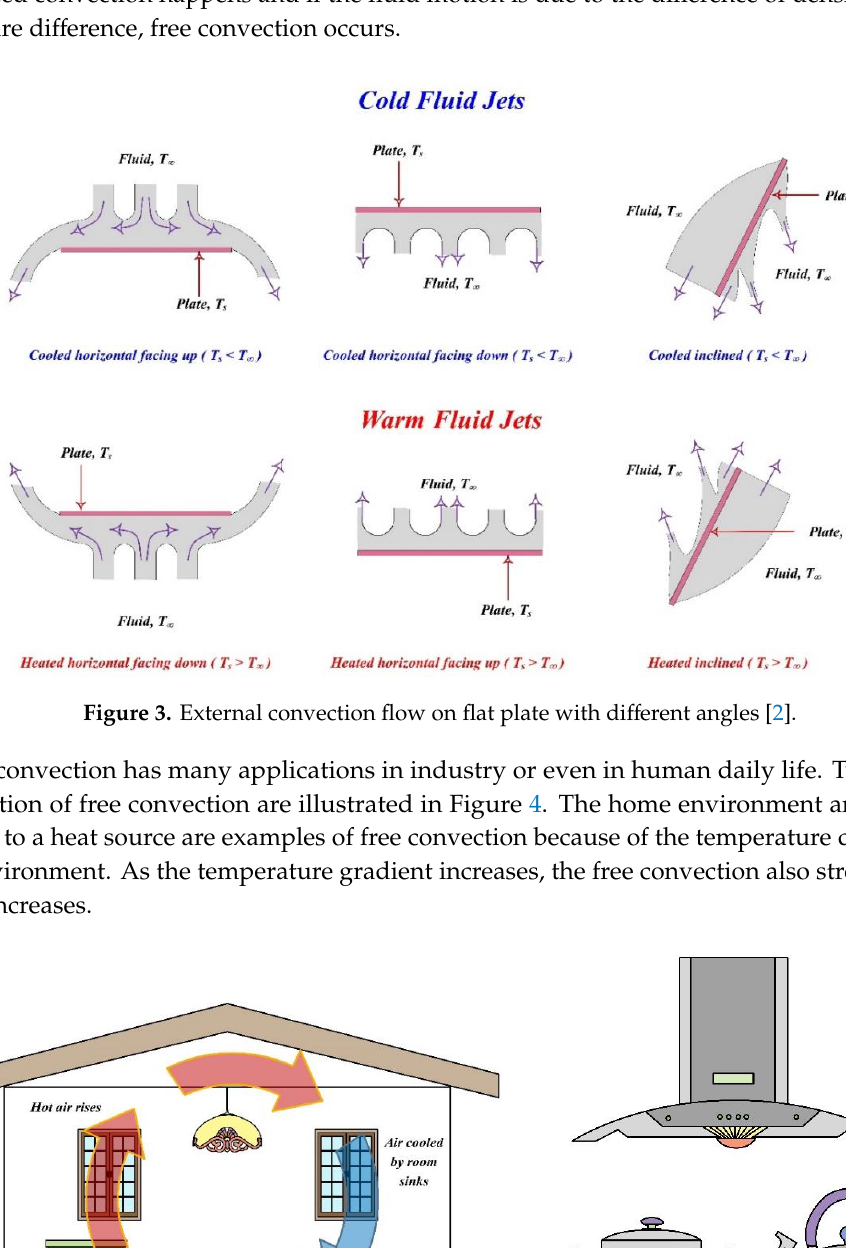
Figure 2. Internal convection flow [2].